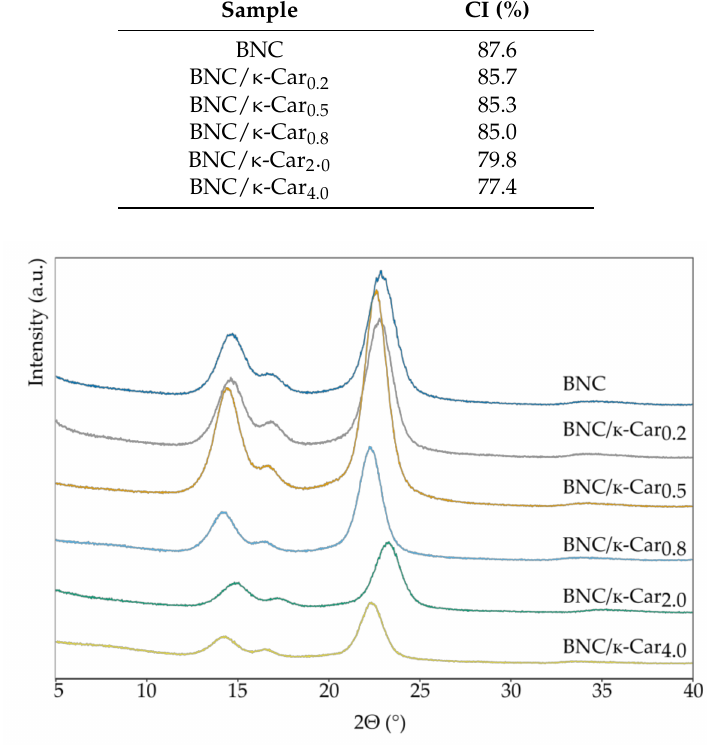
Figure 4. XRD diffraction patterns of BNC/ κ -Car